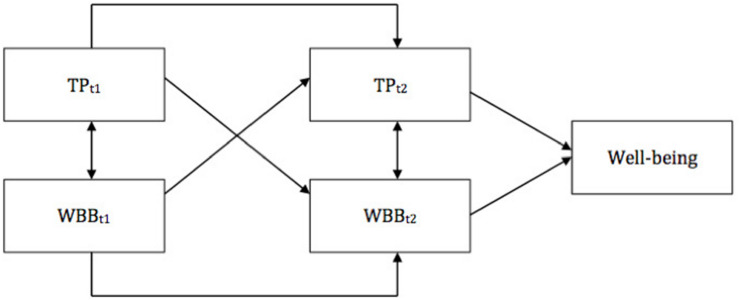
Feedback loop model. TPt1 and TPt2, time points for a particular time perspective; WBBt1 and WBBt2, time points for a particular well-being booster.